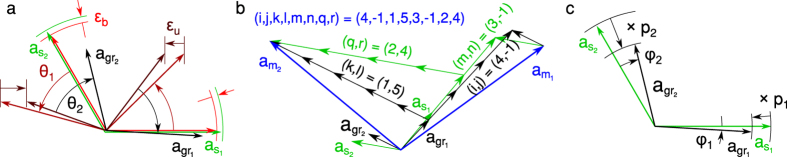
Structural interpretation of a moiré superlattice: (a) The transformation relating graphene lattice vectors  to those of its support  can be decomposed into four steps. (1) Graphene vectors are isotropically rescaled with respect to those of the support (light red). (2) Graphene is rotated with respect to its support (red), in order to determine the direction in which (3) a horizontal rescaling is applied (dark red). (4) A final rotation is applied (black). (b) The lattice vectors of the moiré superlattice decompose into both graphene and support bases, giving (i, j, k, l, m, n, q, r) = (4, −1, 1, 5, 3, −1, 2, 4). (c) Corresponding extended Wood’s notation: (p1
Rφ1 × p2
Rφ2), where p1 and p2 are scaling factors, and φ1 and φ2 are rotation angles.